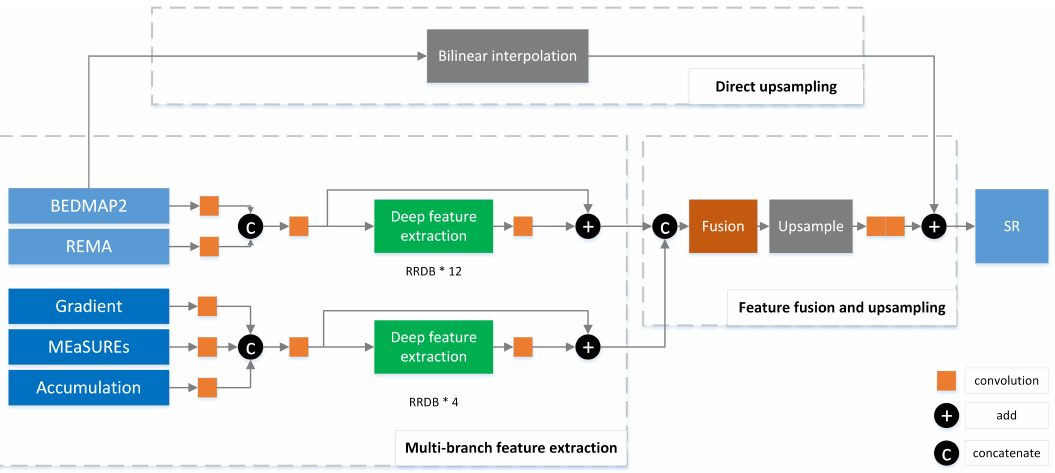
Figure 1. Our multi-branch generator model structure composed of three modules shown in the dotted boxes. The model takes five inputs (BEDMAP2, REMA, gradient of BEDMAP2, MEaSUREs Ice Velocity, and snow